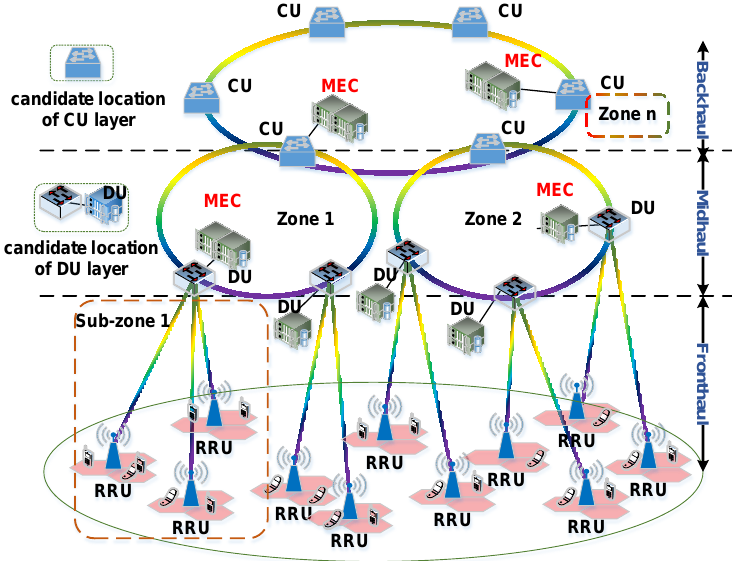
Figure 2. Three-tier C-RAN architecture supporting MEC servers’ deployment.